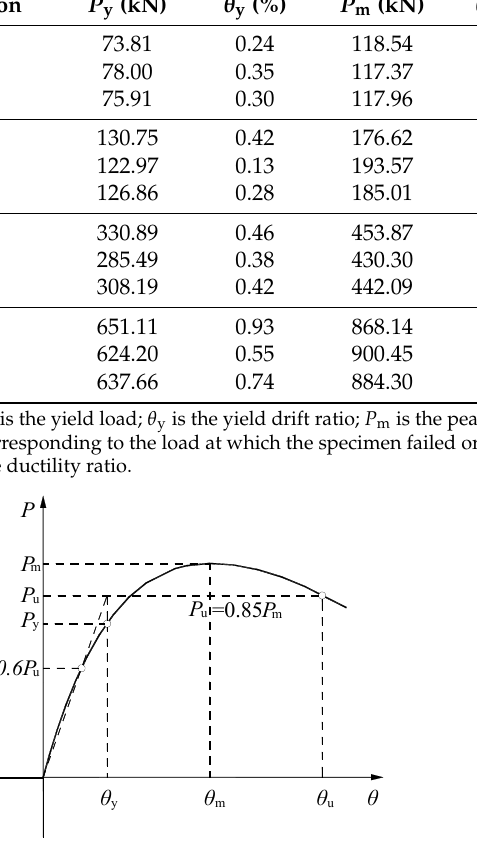
Figure 12. Method of determining the key characteristic points of the tested specimens reprinted form ref. [24].